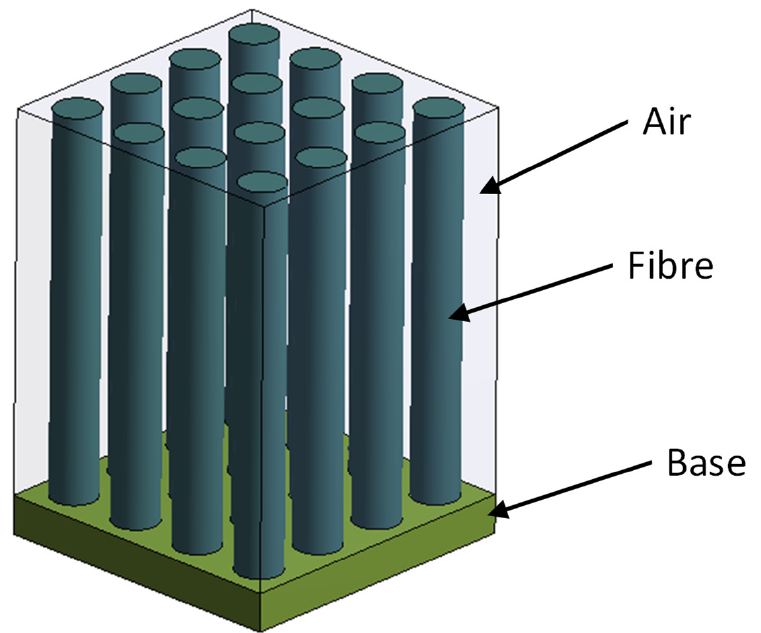
Figure 7. Schematic of the porous turf-like insole.